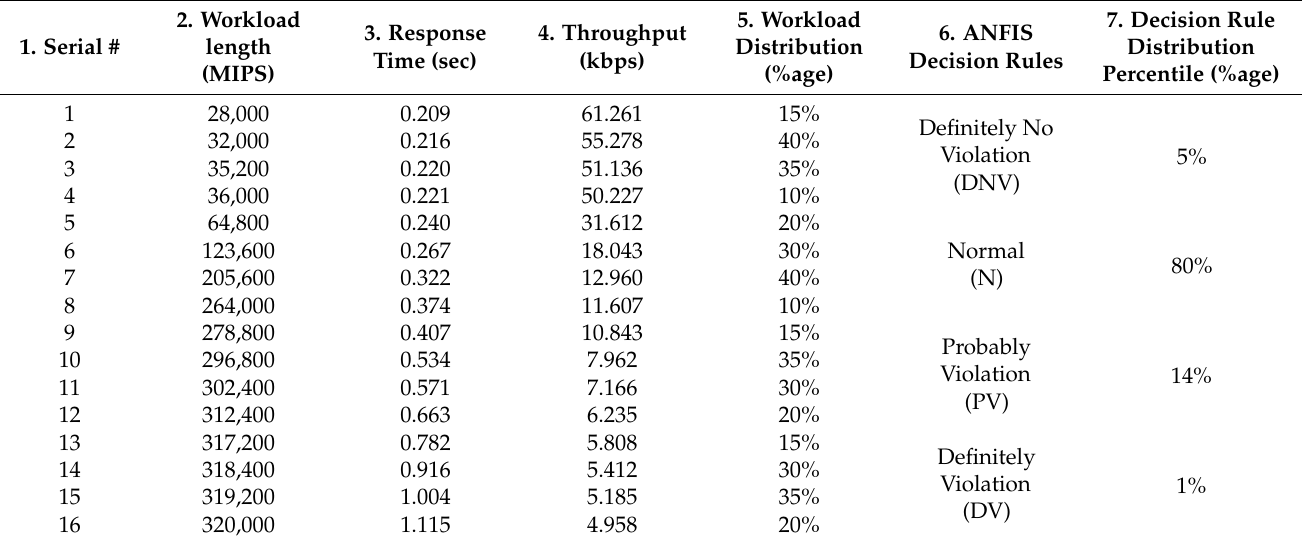
Table 2. QoS Metrics, Workload with Decision